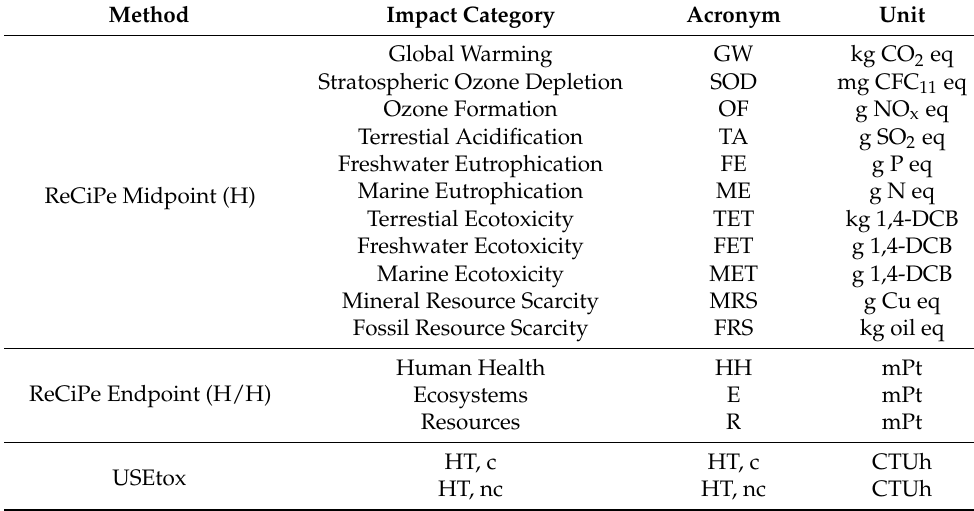
Table 5. Impact categories selected for performing LCA, including its acronyms and